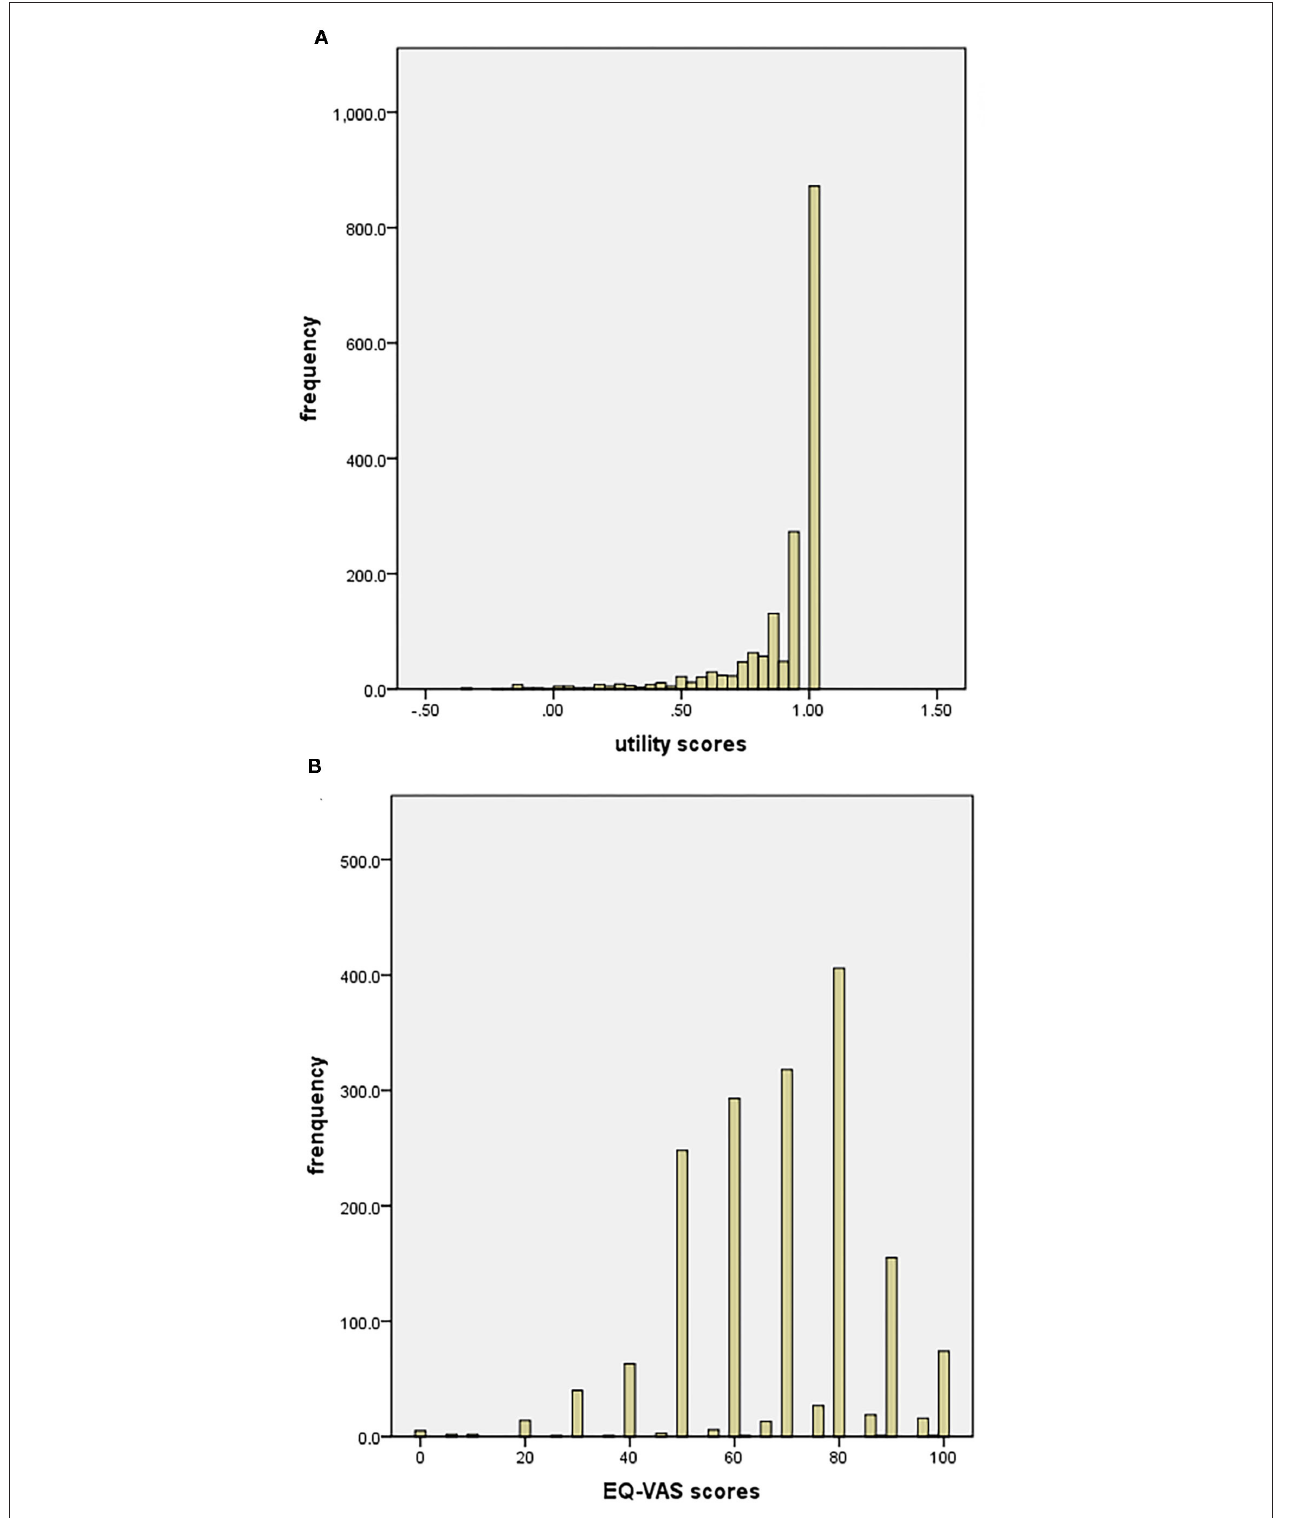
FIGURE 1 | (A) Distribution of EQ-5D-5l scores ( n = 1,709); (B) distribution of EQ-VAS scores ( n = 1,709).